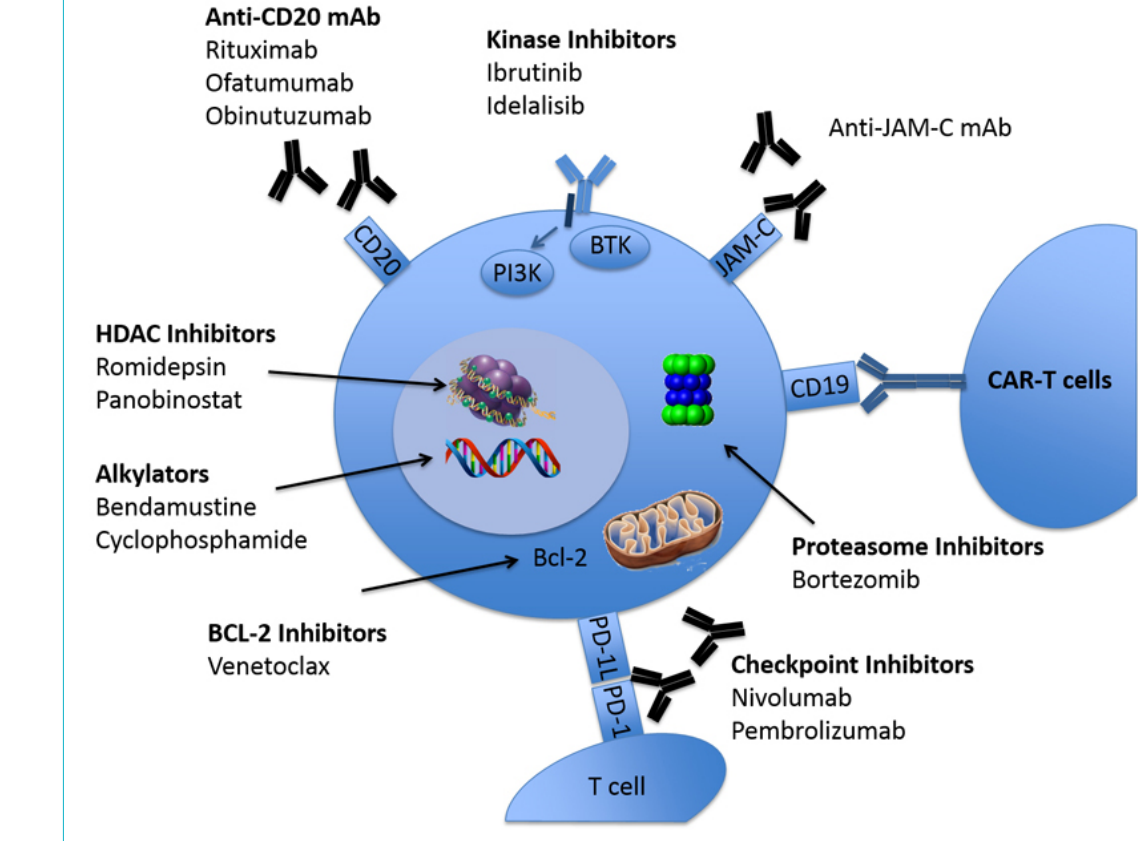
Figure 1: Mechanisms involved in targeting B-cell lymphoma cells. Traditionally, alkylators and anti-CD20 antibodies have been used for B-cell lymphoma treatment. Newly developed drugs target intracellular kinases such as BTK or PI3K, proteasomes, BCL-2 molecules, or HDAC. More recently, modified T-cells (CAR, chimeric antigen receptor), and checkpoint inhibiting monoclonal antibodies have been applied. An alternative approach in the preclinical phase consists of targeting molecules regulating B-cell migration, such as junctional adhesion mole- cule C